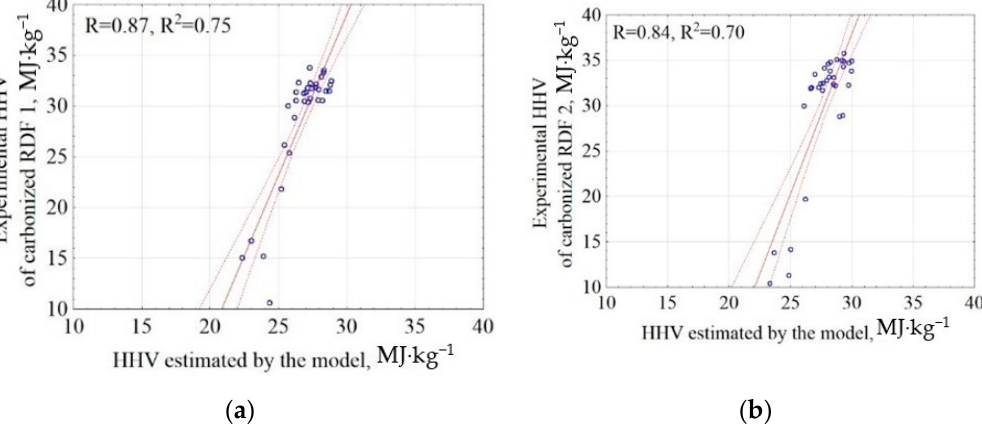
Figure 4. Correlation between experimental and estimated HHV of carbonized RDF blends, ( a ) CSF from RDF blend 1; RDF 1, ( b ) CSF from RDF blend 2; RDF 2. Blue circles are points common for experiments and models.